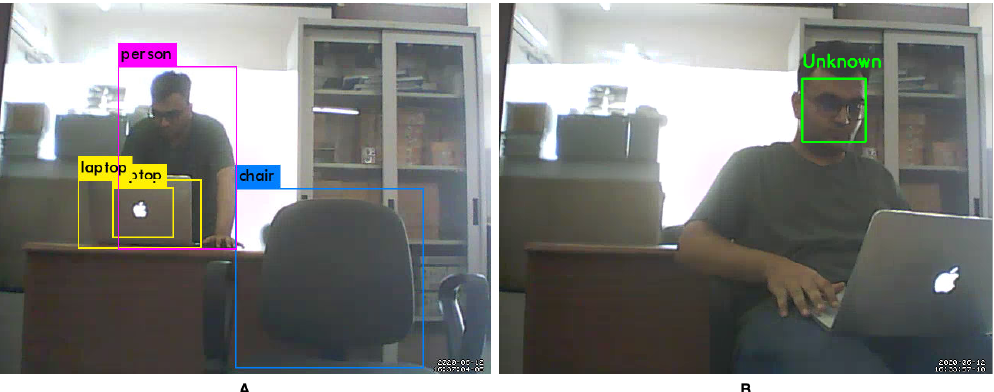
Figure 13. Results of: ( A ) object detection and recognition ( B ) facial detection and recognition